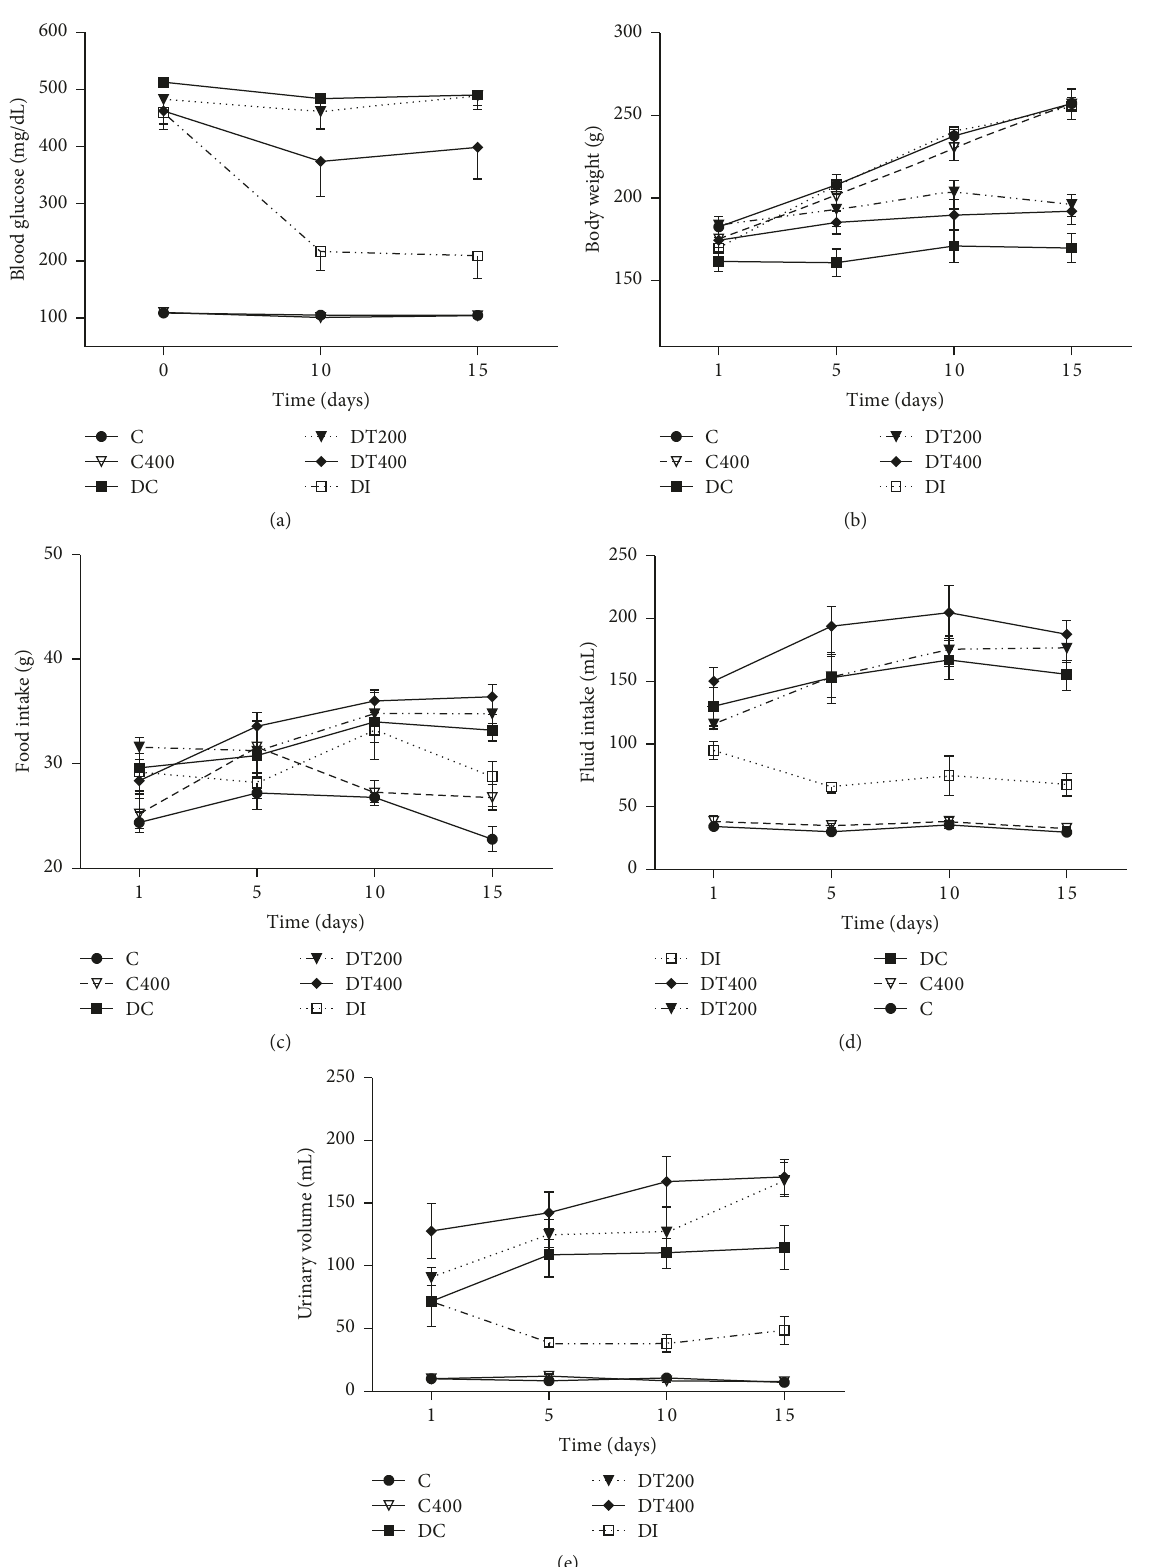
Figure 2: Effect of the EEMn on (a) postprandial glucose, body weight (b), food intake (c), fluid intake (d), and urinary volume (e) of CT400, nondiabetic control rats treated with 400mg/Kg of EEMn; DC, diabetic control; DT200, diabetic rats treated with 200 mg/Kg of EEMn; DT400, diabetic rats treated with 400 mg/Kg of EEMn; DI, diabetic rat treated with insulin (3U/rat). Each point represents the means ± SEM of 6-7